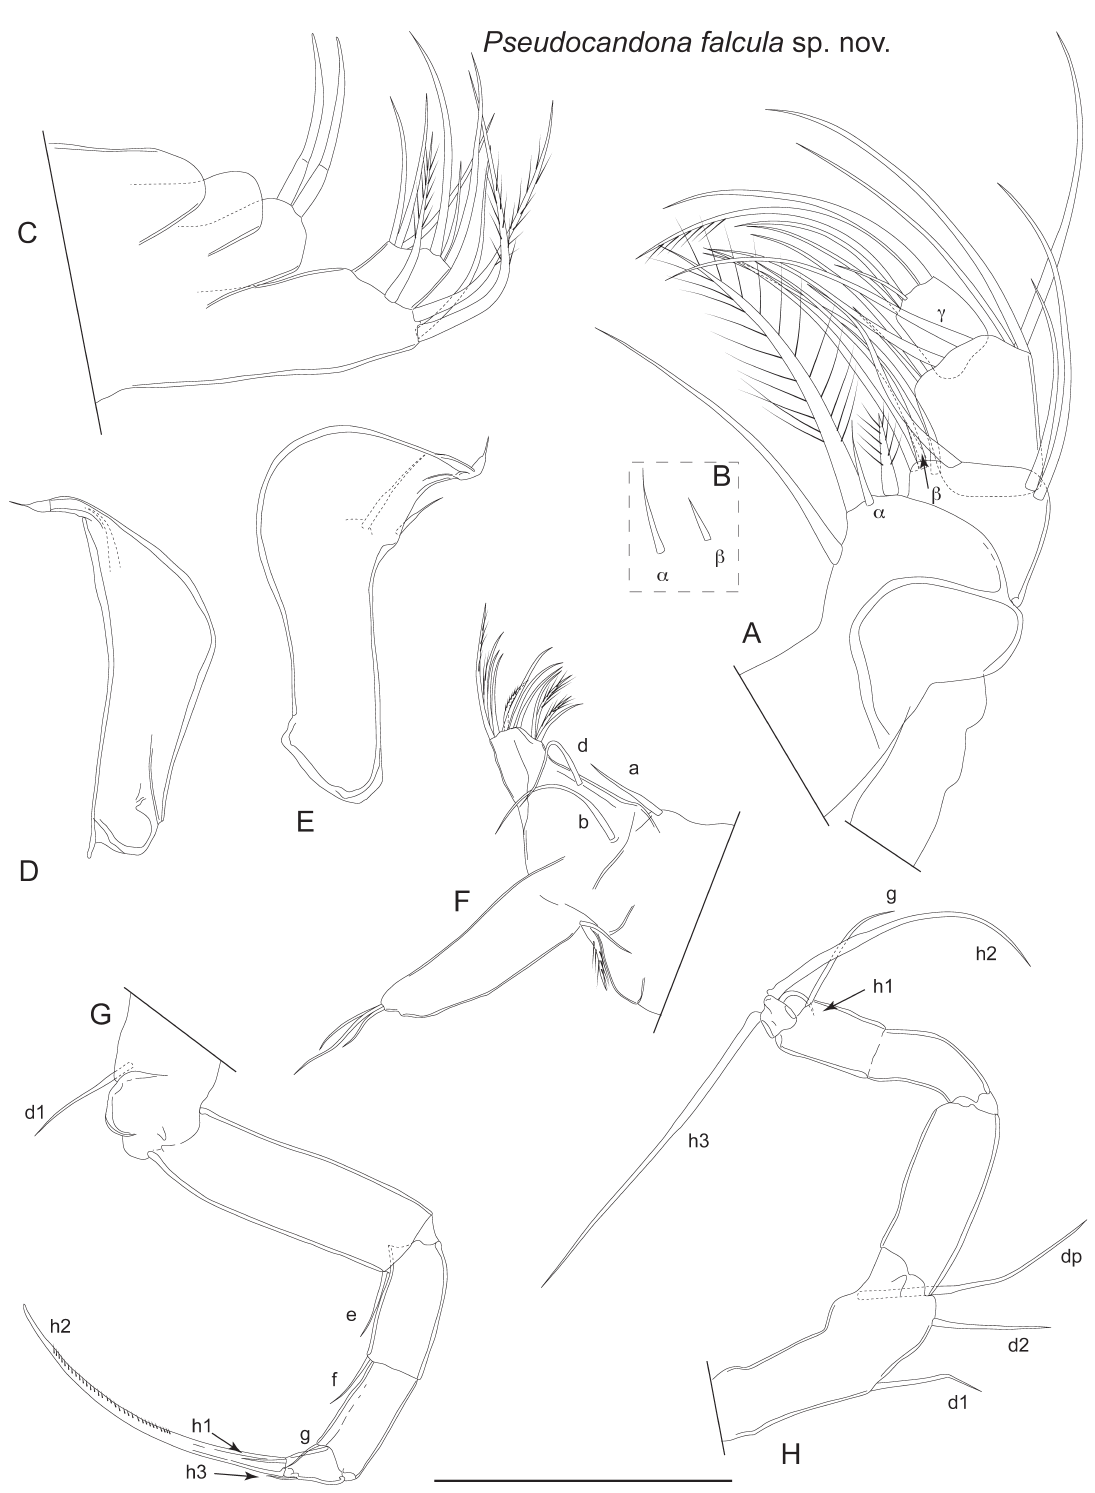
Fig. 12. Pseudocandona falcula sp. nov. A . Male mandibular palp (LBM 1430006275). B . Detail of alpha and beta setae of mandibular palp (LBM 1430006275). C . Male maxillula (setae on endites not drawn) (LBM 1430006275). D . Male left fifth limb palp (LBM 1430006275). E . Male right fifth limb palp (LBM 1430006275). F . Female fifth limb (LBM 1430006276). G . Male sixth limb (LBM 1430006275). H . Male seventh limb (LBM 1430006275). Scale bar: A–C = 82 µm; D–H = 151